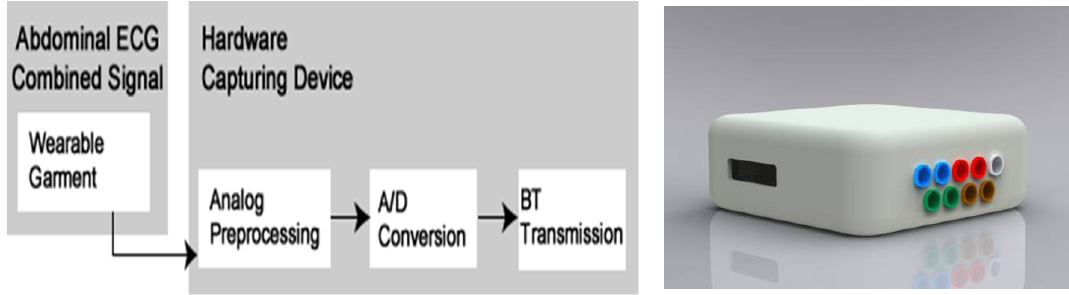
Figure 4. The block diagram of the hardware capturing device ( left ) and its box ( right ).